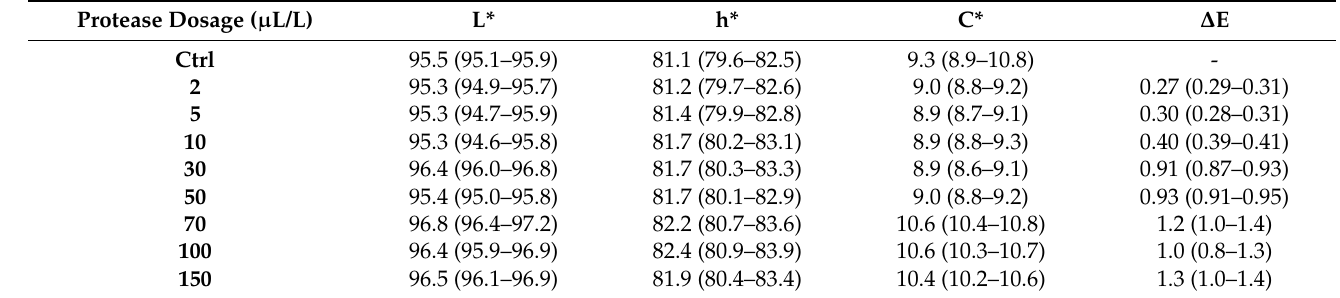
Table 4. Visual color attributes (L*, hue (h*), chroma value (C*) and total color difference ( ∆ E)) of white must wine subjected to enzymatic addition (protease in the range of 2–150 µ L/L) after treatment I (cold settling prior to AF). Ctrl is clarified must with the only pectinolytic enzyme.